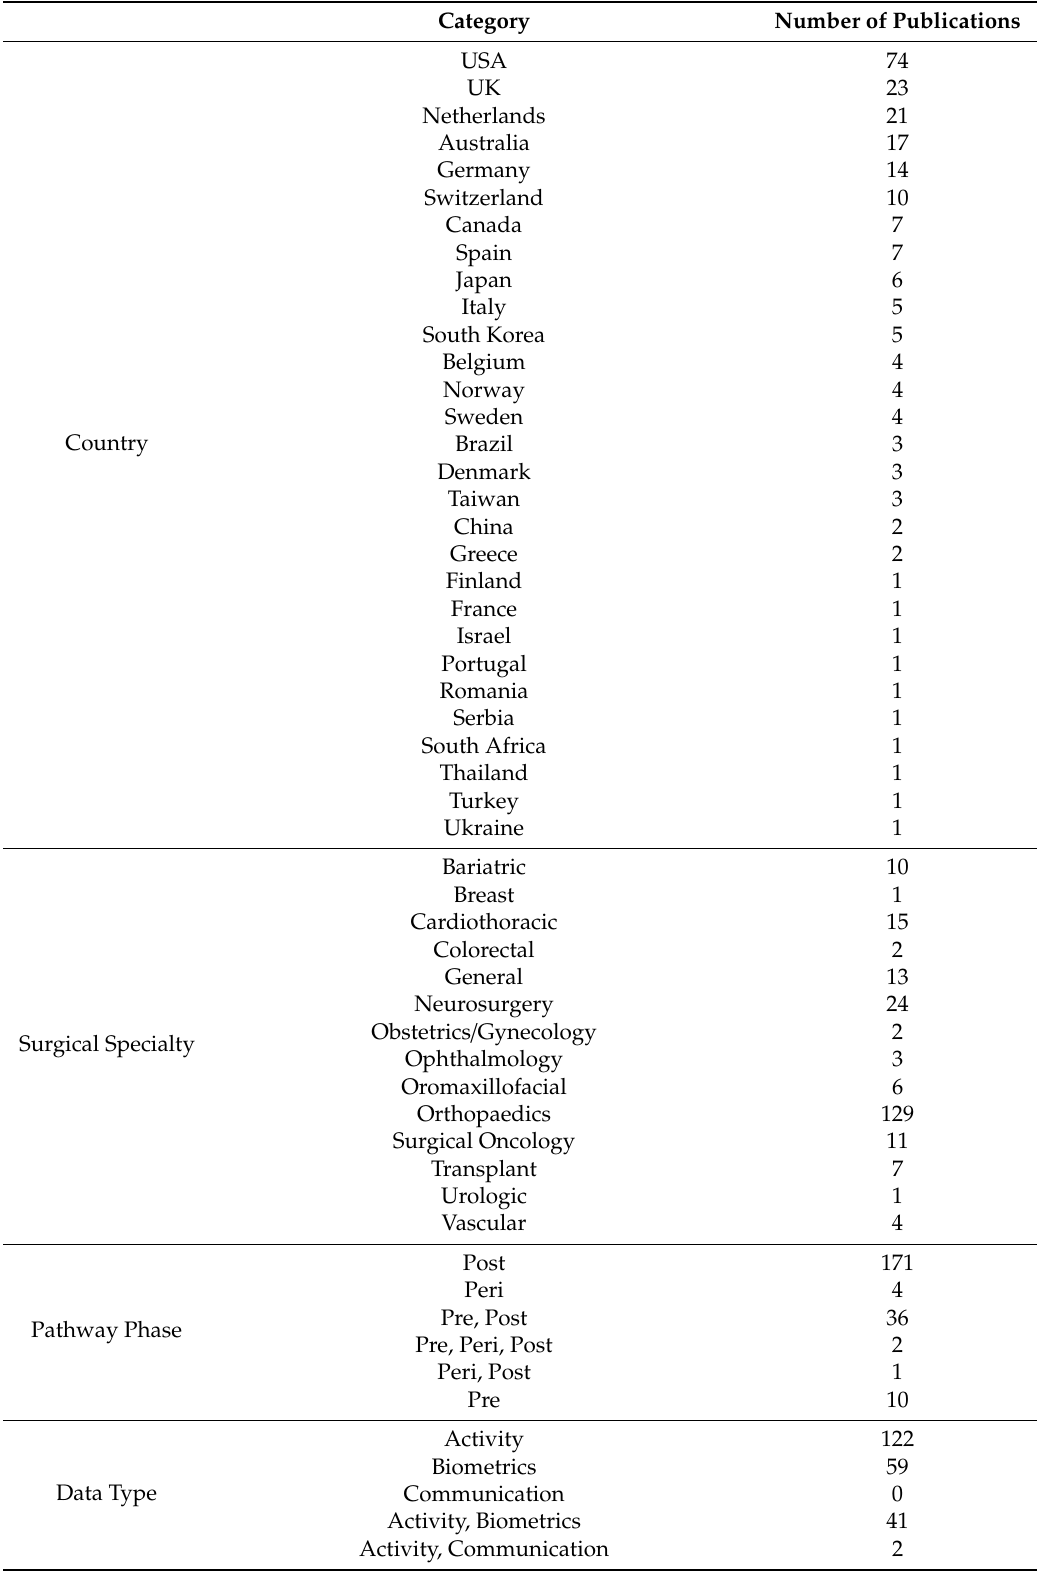
Table 1. Summary of number of publications within country, surgical specialty, pathway phase, data type, and function